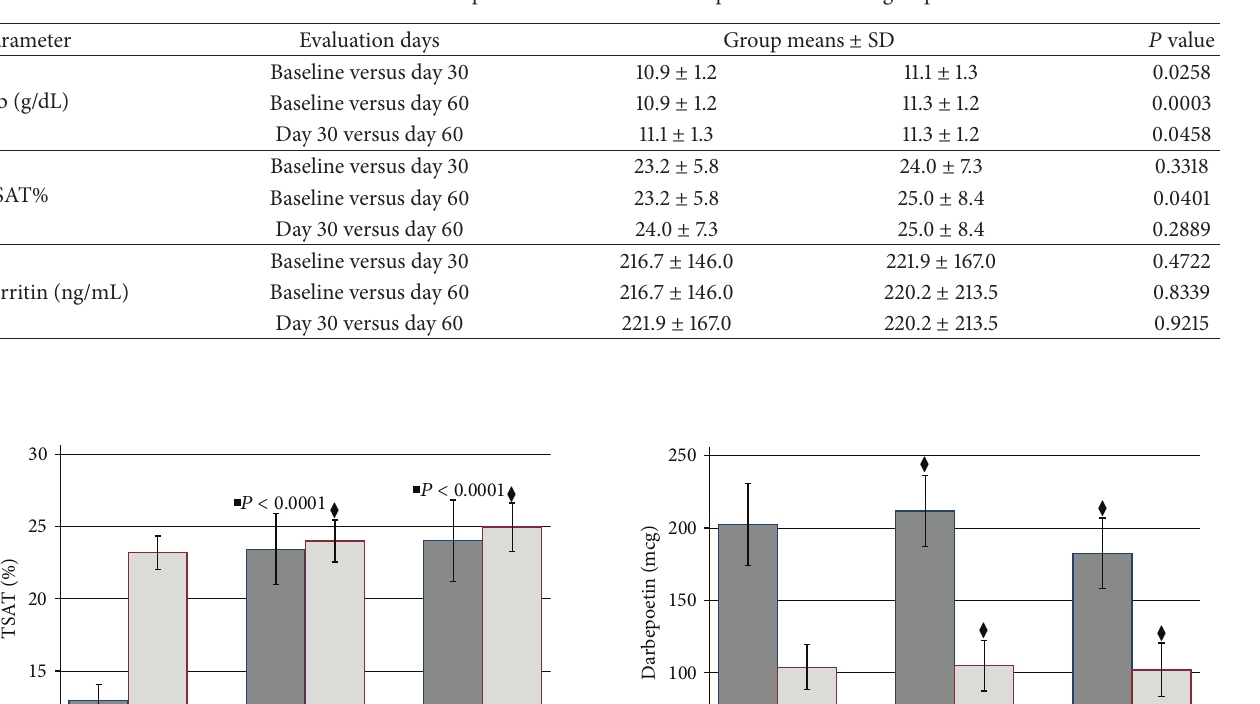
Table 3: Parameter comparison at three evaluation points in oral iron group.